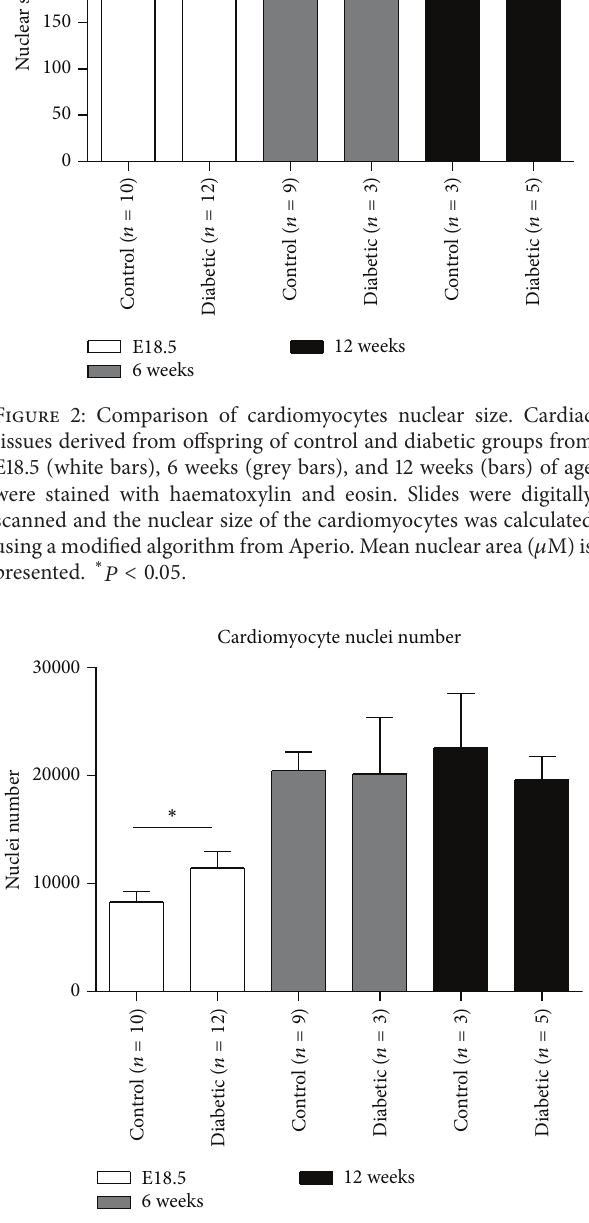
Figure 3: Comparison of cardiomyocytes nuclear number. Cardiac tissues derived from offspring of control and diabetic groups from E18.5 (white bars), 6 weeks (grey bars), and 12 weeks (bars) of age were stained with haematoxylin and eosin. Slides were digitally scanned and the number of nuclei of the cardiomyocytes was calculated using a modified algorithm from Aperio. Mean nuclear number is presented. ∗ 𝑃 < 0.05 .